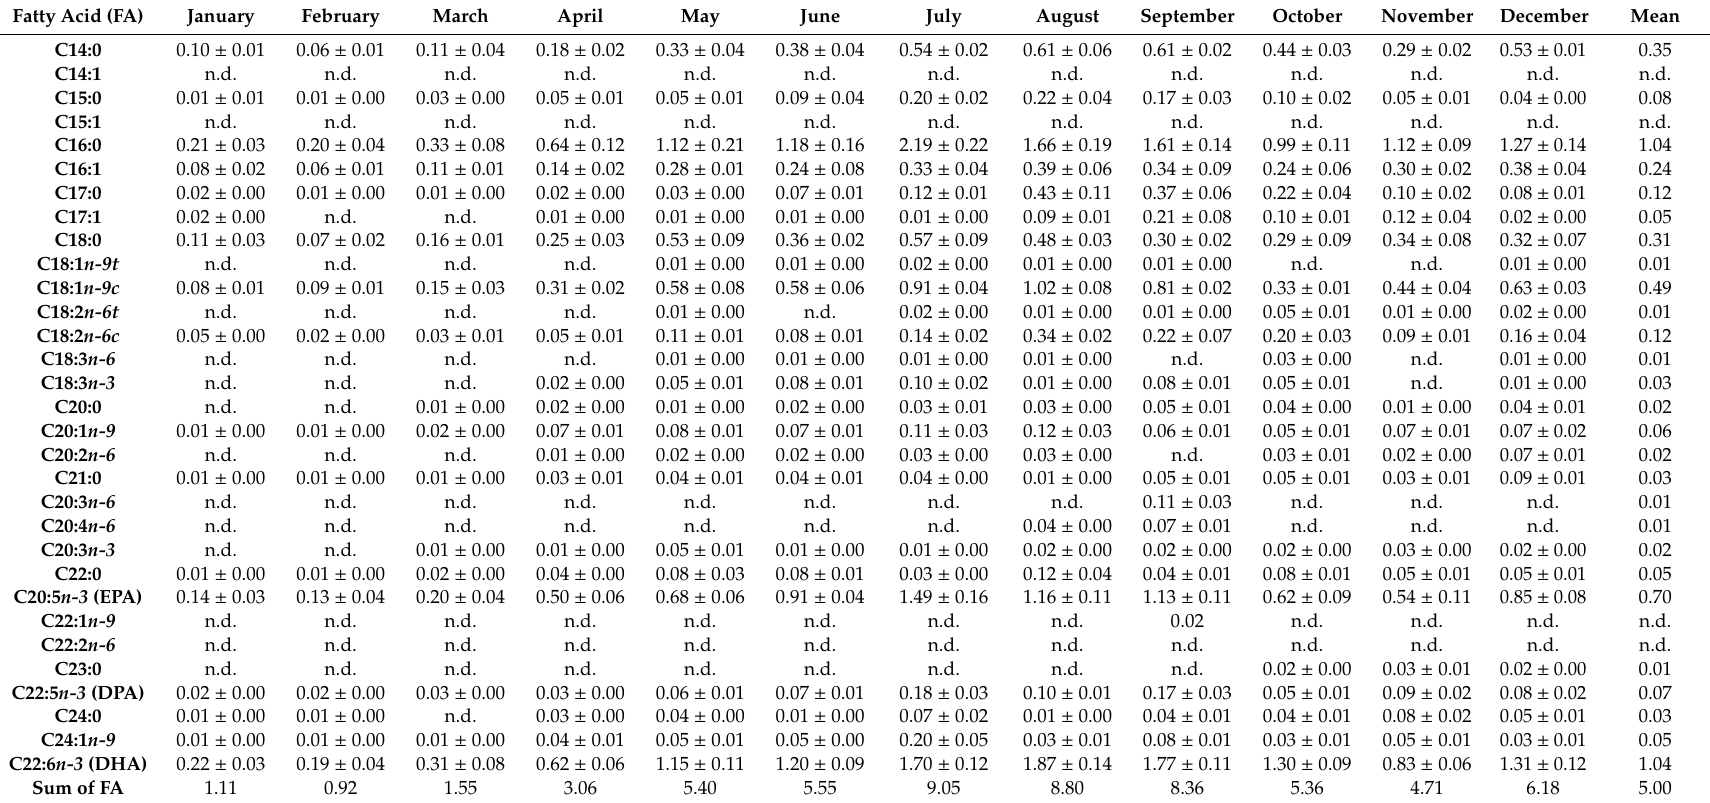
Table 3. Seasonal changes in the fatty acid composition of the sardine g / 100 g wet weight ( n =